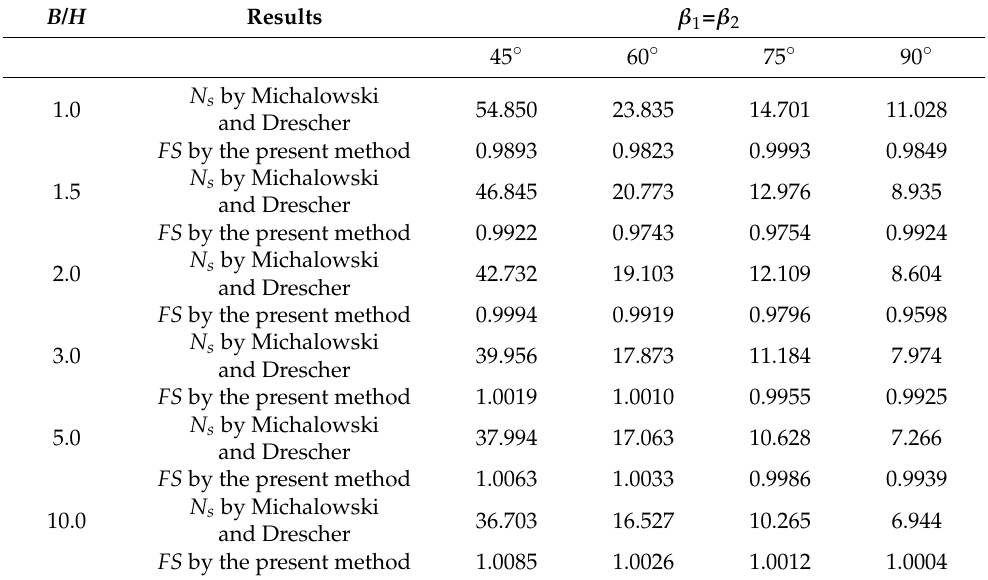
Table 1. Comparisons of both the present outcomes and the solutions of Michalowski and Drescher [12], corresponding to λ a = 0.0, m = 1, k h = 0.0. B /